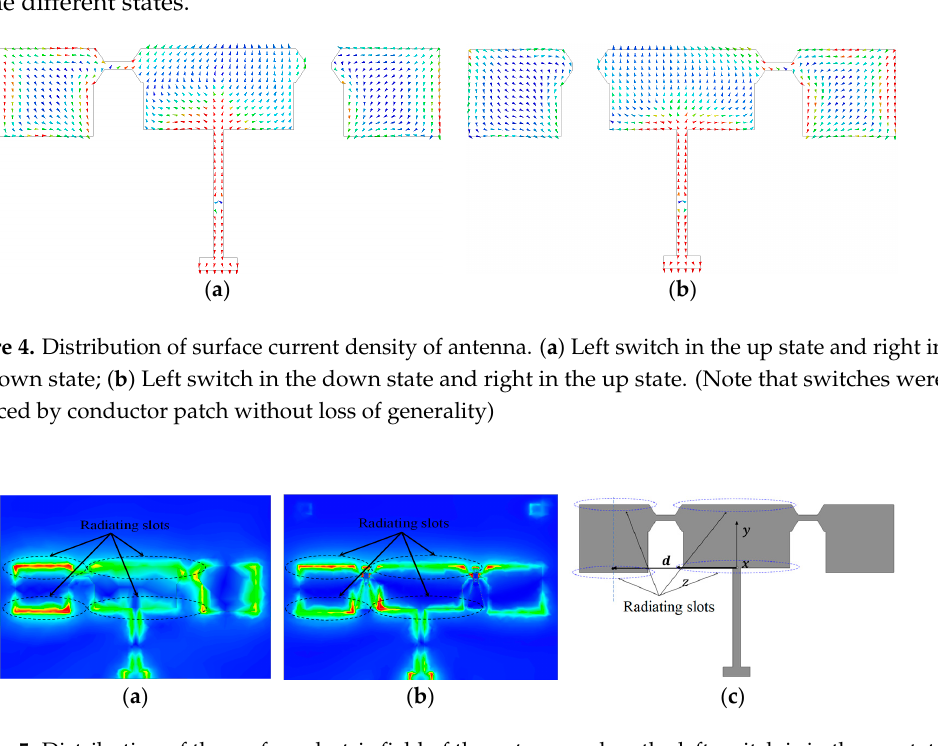
Figure 5. Distribution of the surface electric field of the antenna, when the left switch is in the up state and the right is in the down state. ( a ) Switches were replaced by a conductor patch; ( b ) Using RF MEMS switches; ( c ) The coordinate frame for field calculation. The relative value of surface electric field was represented by rainbow color, red and violent represent maximum and minimum respectively.